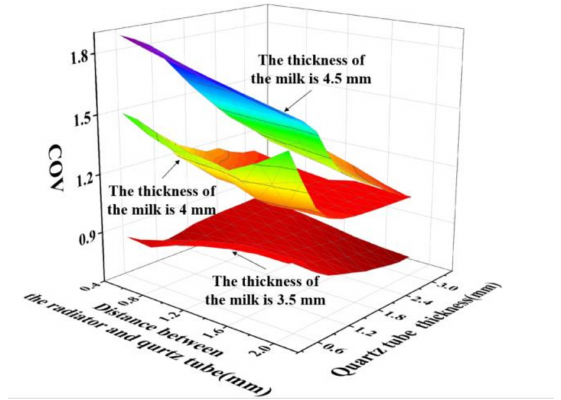
Figure 8. COV simulation results of the microwave system for different